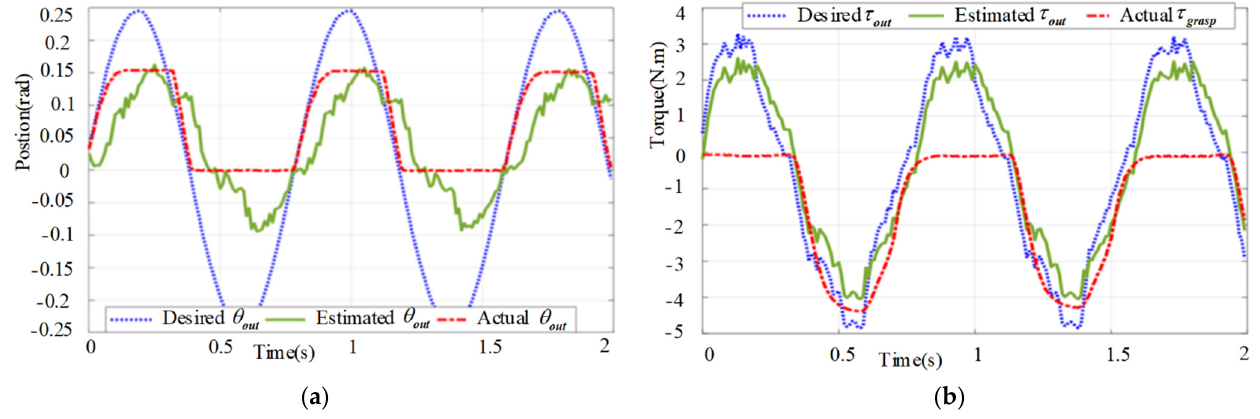
Figure 11. Comparison of the output displacement and torque estimation of the cable-pulley system with measured data: ( a ) The estimated output displacement of the distal grasper of the cable-pulley system; ( b ) The estimated output torque of the distal grasper of the cable-pulley system.